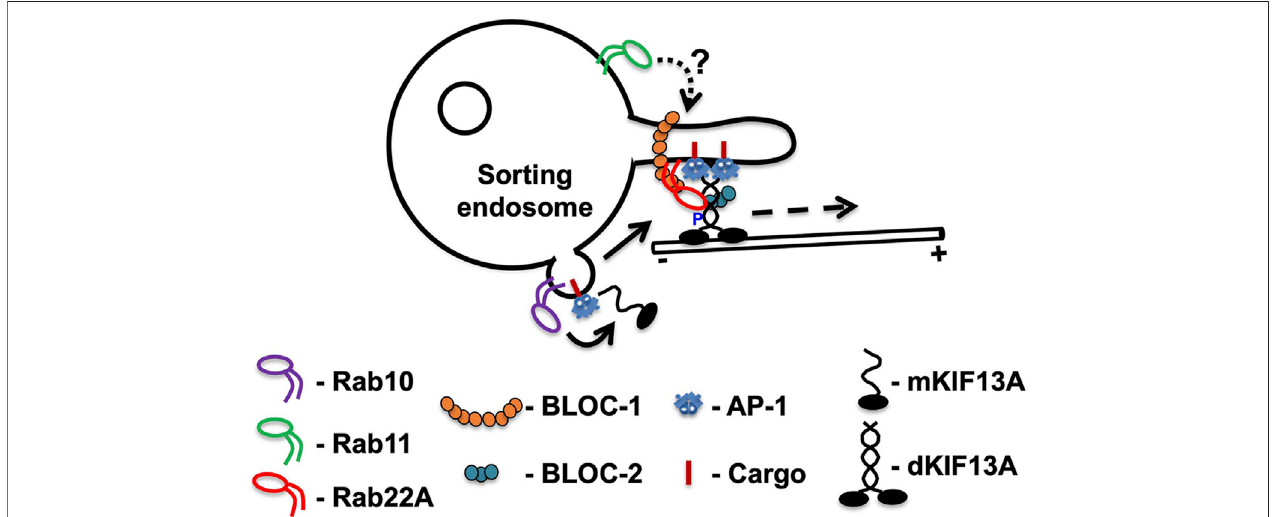
FIGURE 2 | The current model of KIF13A functions in regulating RE dynamics. Based on published studies, we propose a model for KIF13A regulation on RE dynamics (length and number). Monomeric (m) KIF13As are recruited to sorting endosomes upon activation of Rab10 (physically binds to C-terminal tail of KIF13A) to cargo sorted endosomal buds (bent arrow). These monomeric KIF13A forms homodimers (d) or heterodimers by pairing with KIF13B (not shown). The P390 in the KIF13A monomers inhibits the formation of a dimer, which will be relieved by active Rab22A on endosomal buds. Rab22A interacts with KIF13A at the NC-CC1 domain andfacilitatesdimerizationandmotoractivation.ThetaildomainofdimericKIF13Aassociateswithcargothroughcargoadaptor AP(adaptorprotein)-1,andthe motor domain associates with microtubules. During this process, Rab22A recruits BLOC-1 and BLOC-2 to the endosomal bud and facilitates the elongation and extension of endosomal buds into REs with the help of KIF13A along the microtubule tracks. Note that the REs are generated due to balanced tug-of-war between dyneinandKIF13Amotorsduringthetubuleextension(notshown).WehypothesizeeitheraRabswitch(indicatedasanarrow)orRabcoordinationbetweenRab10and Rab22AduringdimerizationandactivationofKIF13A.Thedashedarrowrepresentsthedirectionofelongationtowardsthe+endofthemicrotubule.Wealsopredictthat Rab11A functions as an upstream factor and regulates the endosomal maturation and initial stages of RE formation. Even though Rab11 interacts directly with KIF13A, its precise role in regulating the KIF13A function requires investigation (shown as dashed arrow with ?).